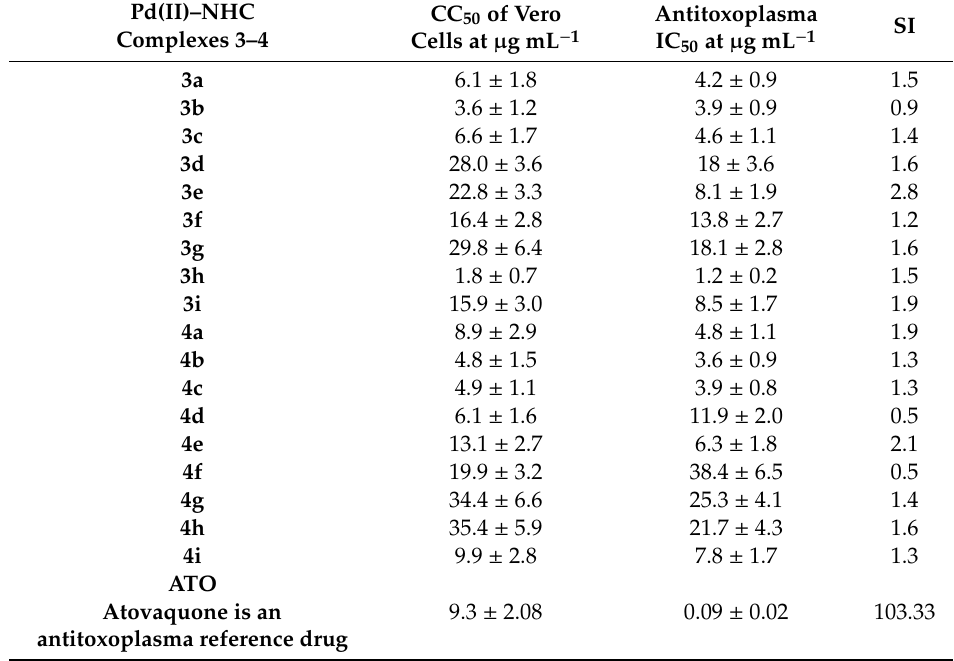
Table 4. Antitoxoplasmal activity of Pd(II)–N-heterocyclic carbene (NHC) complexes 3–4 against T. gondii